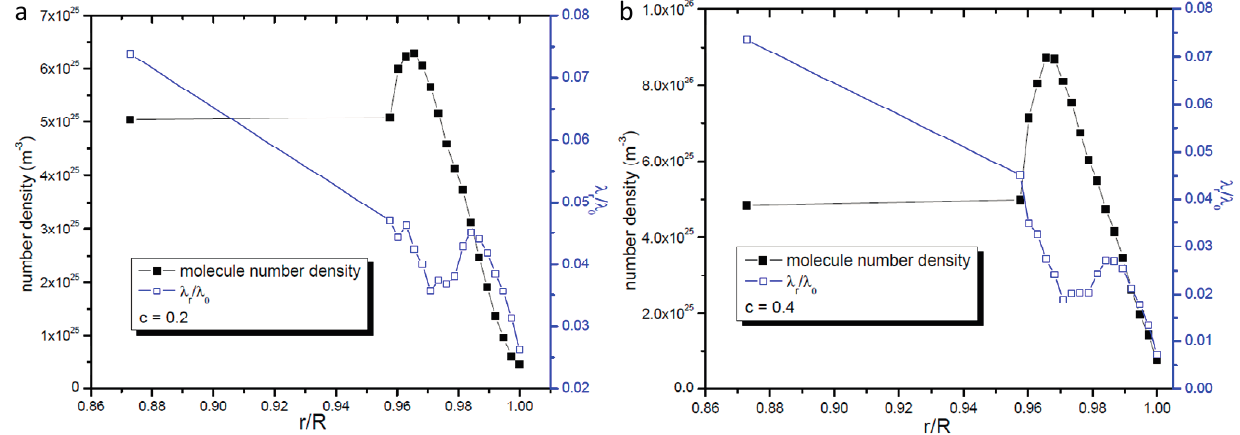
Figure 8. Profiles of radial gas molecular mean free path and gas number density in the zone 0.7 nm apart from the nanopore’s wall surface. ( a ) c = 0.2; ( b ) c = 0.4; and ( c ) c =